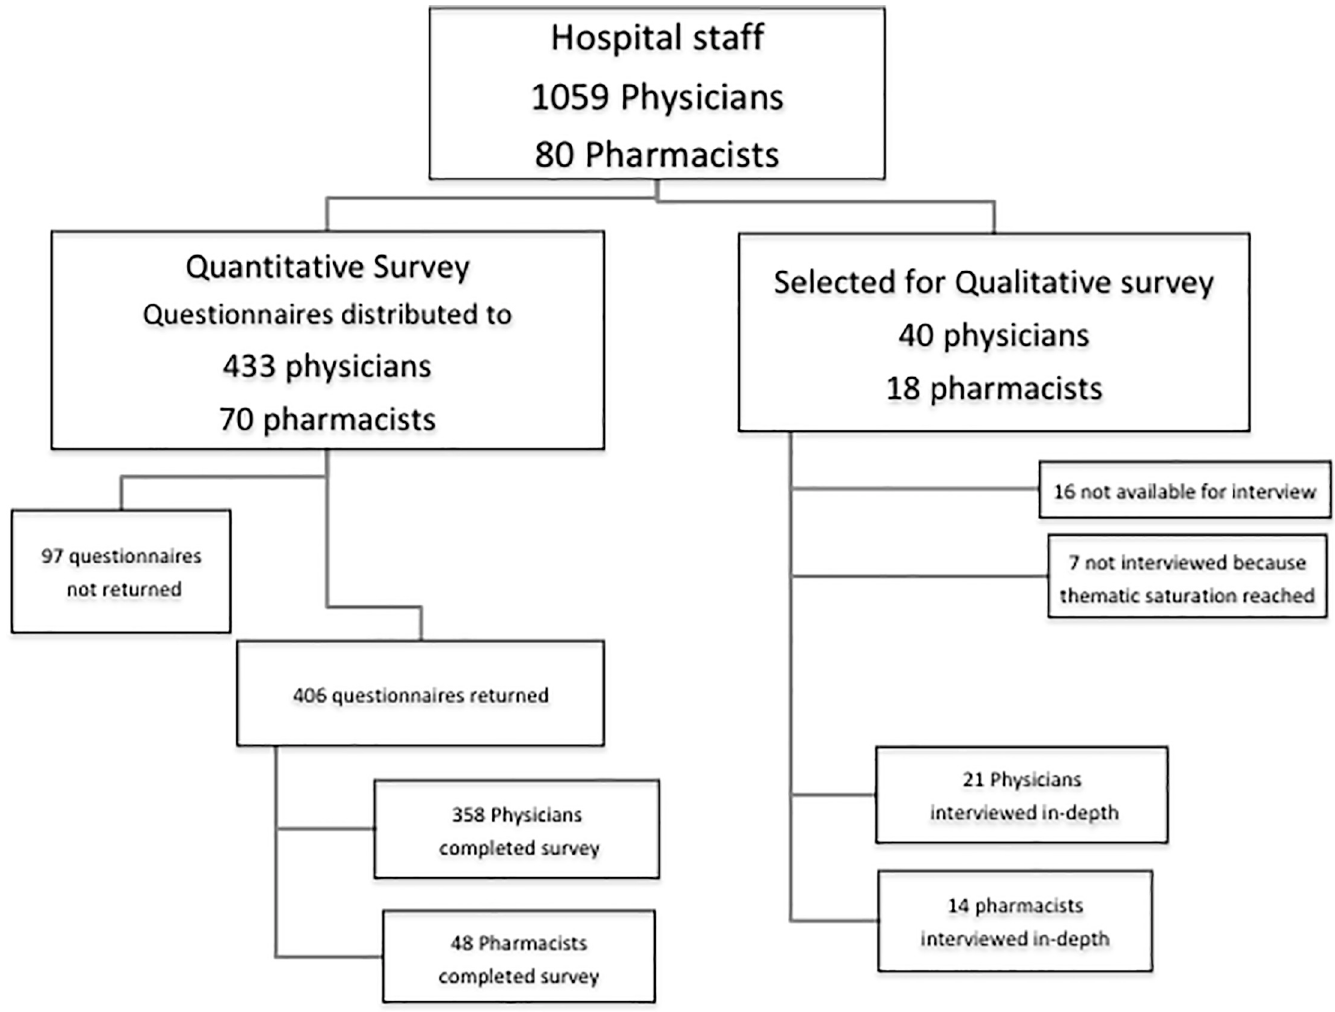
Fig 1. Flow chart of participant enrollment for the quantitative and qualitative surveys.